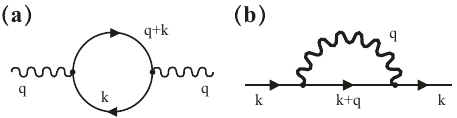
Fig. 3 Renormalized bubble diagrams. a The fermion bubble induced boson dynamics. b The renormalized fermion propagator from the renormalized boson correlator. The light and bold curly line represent the bare and renormalized boson correlators,